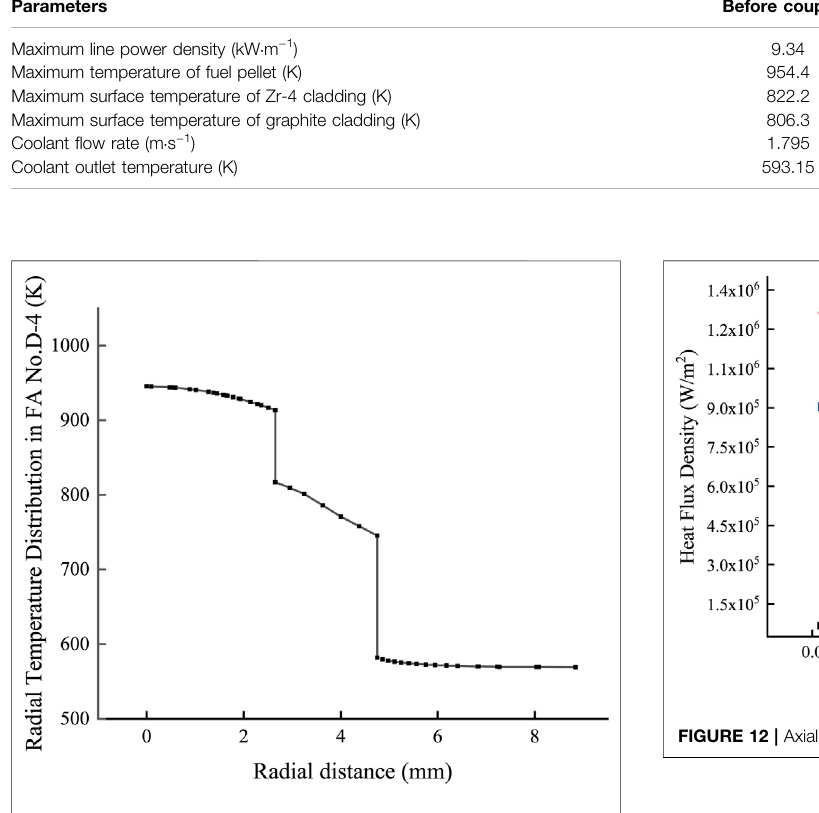
Figure 12 . In fl uenced by the power distribution, the actual heat fl ux is high in the middle and low at both ends. Because the body temperature of coolant keeps increasing from inlet to outlet, the critical heat fl ux decreases along the axial height. Based on the ratio of the critical heat fl ux and actual heat fl ux, the variation of DNBR at rated power and steady state is obtained. The minimum departure from the nucleate boiling ratio is calculated as 2.41 at axial height z = 1.15 m, behind the maximum heat fl ux point, which is at axial height z = 0.95 m.